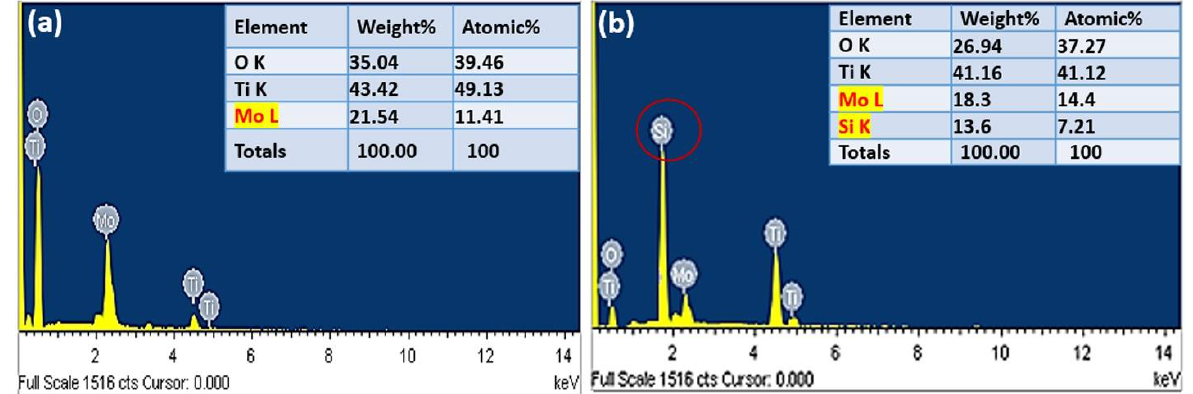
Figure 2. EDS analysis on the surface of the coatings obtained in ( a ) Bath A and ( b ) Bath B.